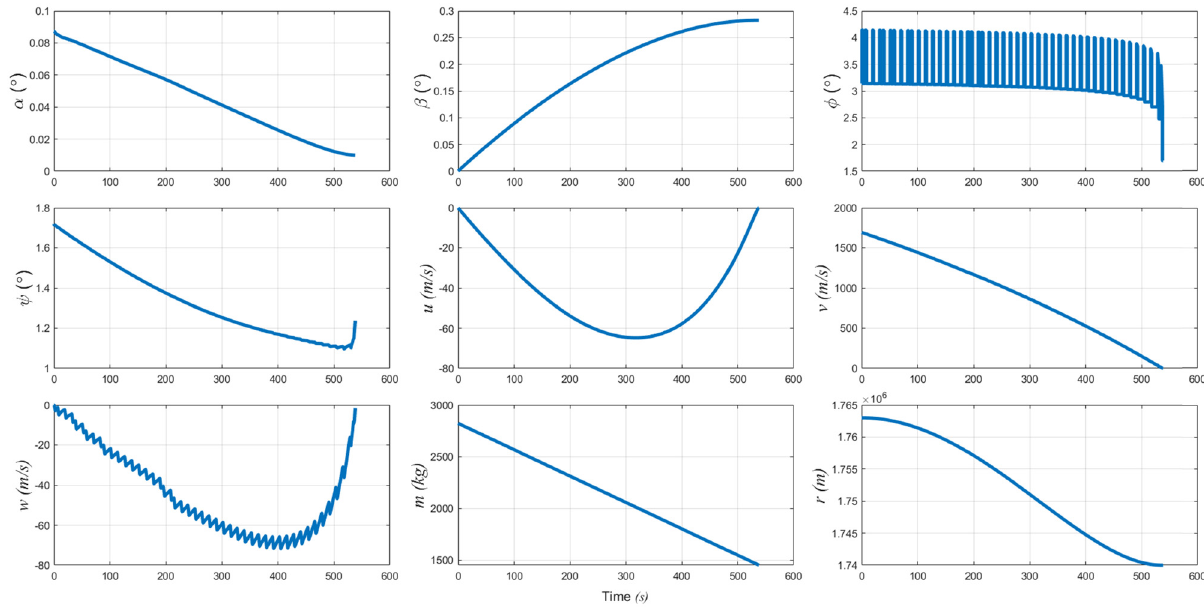
Figure 5: Latitude, longitude, attitude angle, velocities, and distance of the VSSM + PWM lander.